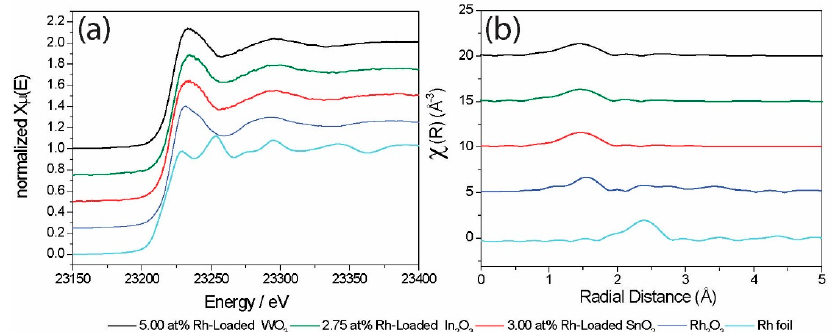
Figure 4. Rh K-edge X-ray absorption near-edge structure (XANES) spectra ( a ) and Fourier transform (FT) k 3 -weigthed extended X-ray absorption fine structure (EXAFS) spectra ( b ) of Rh-loaded sensing materials ( amplitude × 2 ) , Rh 2 O 3 reference ( amplitude × 2 ) , and Rh foil